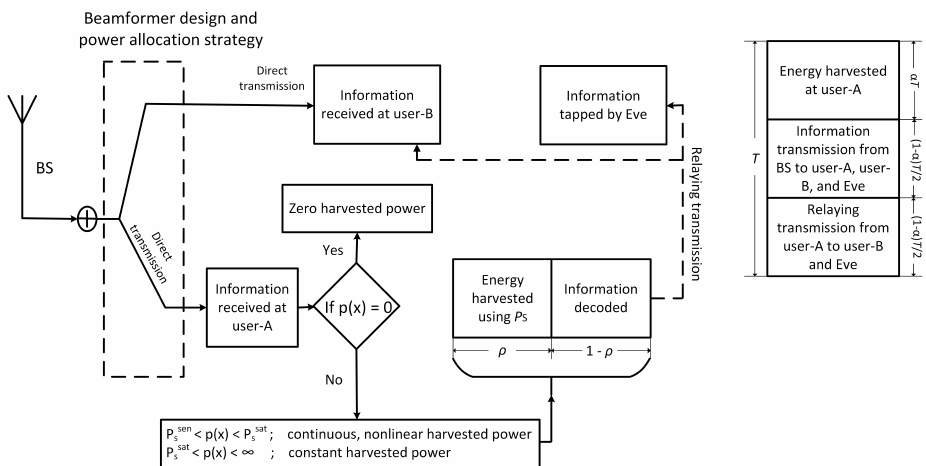
Figure 2. A hybrid simultaneous wireless information and power transmission (SWIPT) time switch- ing/power splitting (TS/PS)